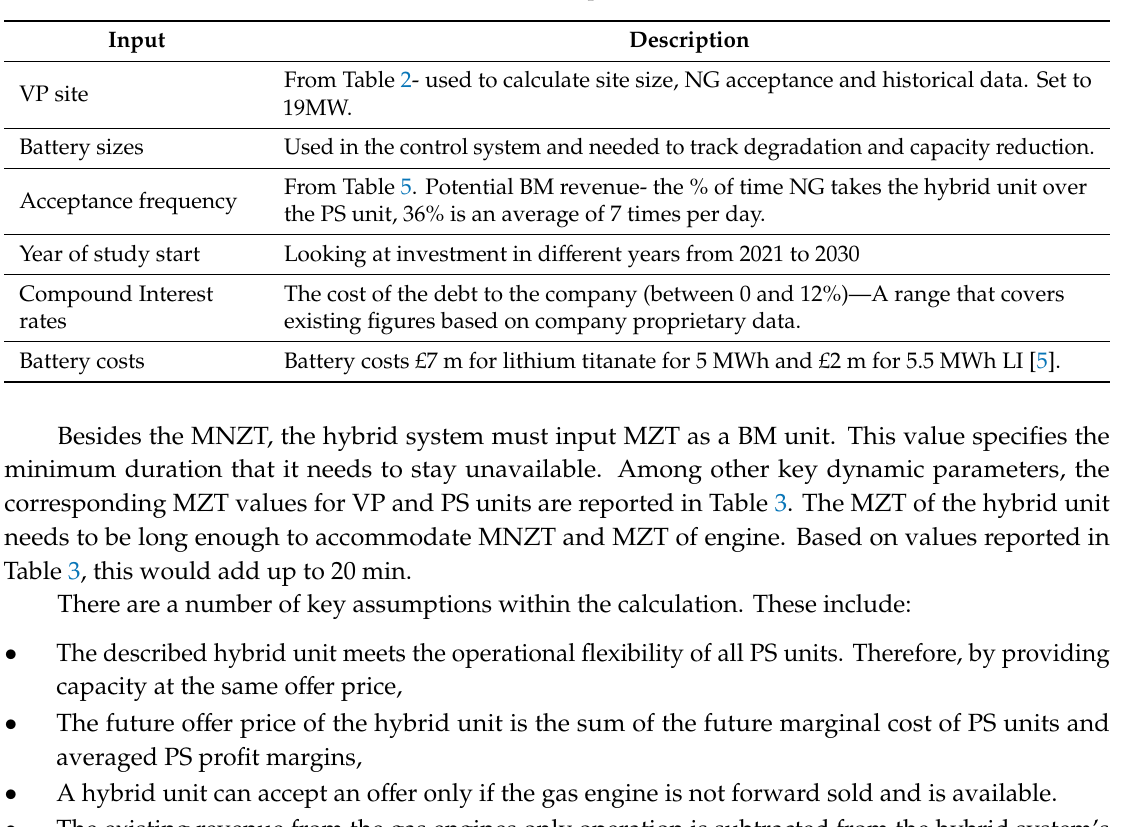
Table 9. Variable data inputs to the